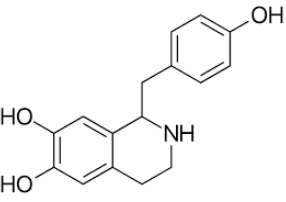
Figure 19. Chemical structure of higenamine. Formula: C 16 H 17 NO 3.